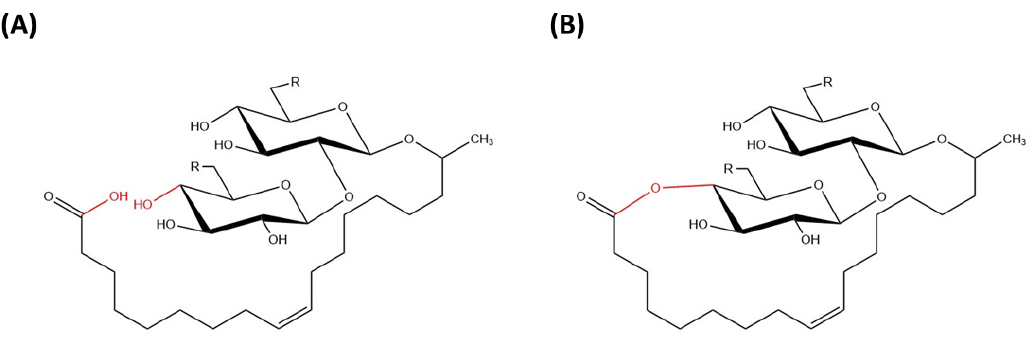
Figure 2. Chemical structure of ( A ) acidic sophorolipid ( B ) lactonic